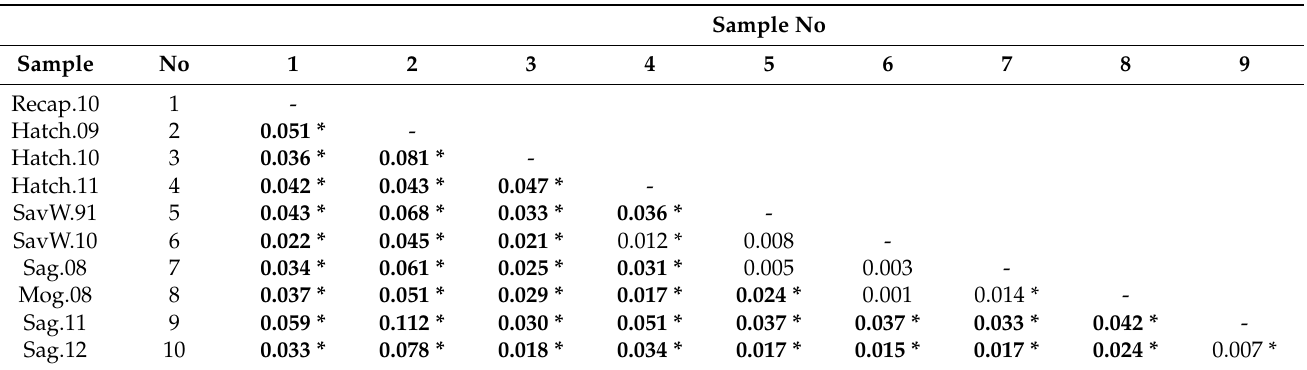
Table 4. Pairwise F ST of the ten analyzed samples. Significant tests * ( p < 0.05), and significant after Bonferroni correction (i.e., p < 0.001) in